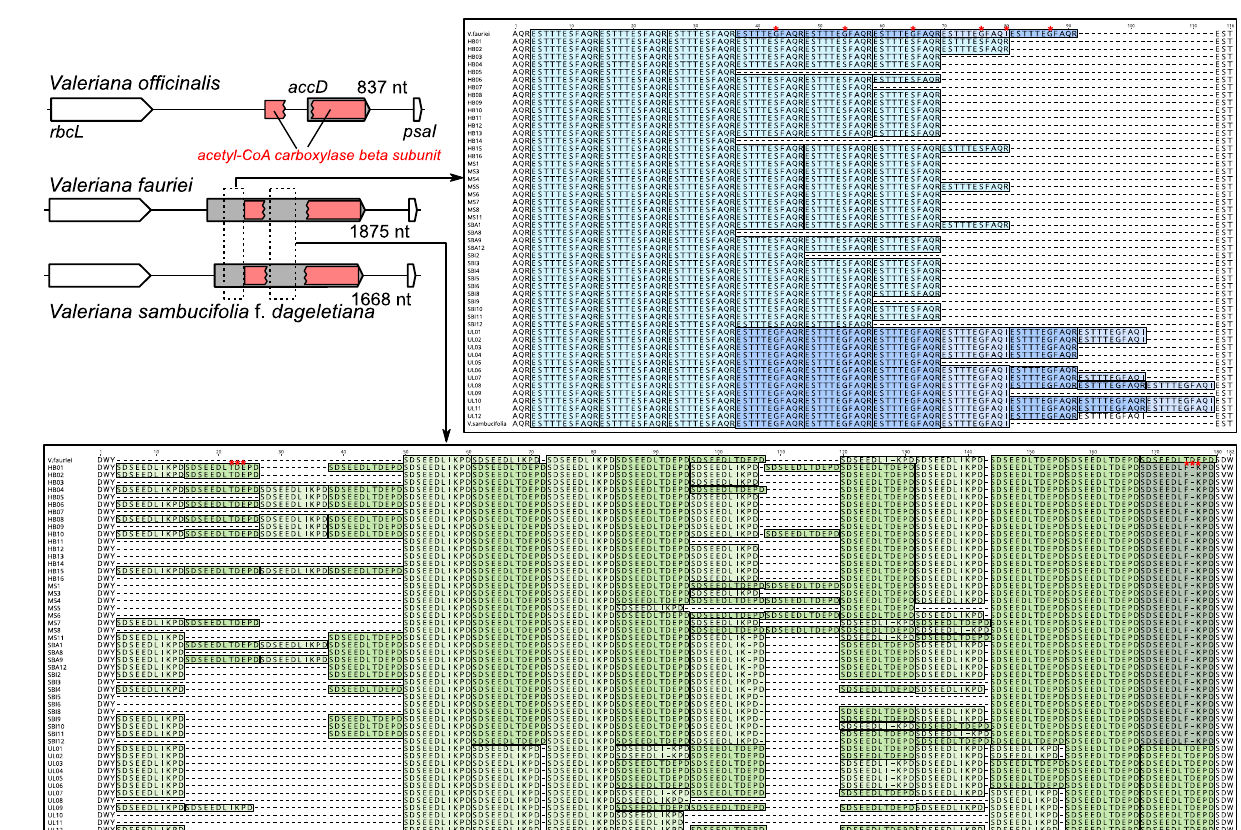
Figure 4. Length variation in the plastid accD of Valeriana . Schematic diagram of the genomic regions surrounding the accD from three Valeriana species. Gray boxes indicate the predicted open reading frames (ORFs). Red rectangles indicate the con- served domain in the ORFs. Dashed boxes indicate two hotspot regions in the accD gene. Each amino acid sequence of the two hotspot regions of the accD copies from 52 Valeriana individuals. Blue and green boxes indicate amino acid repeat (AAR) motifs. Asterisks indicate an amino acid sequence mismatch of the AARs (ESTTTESFAQR and SDSEEDLIKPD), respectively. V. fauriei : HB, MS, SBA, and SBI; V. sambucifolia f. dageletiana : UL.